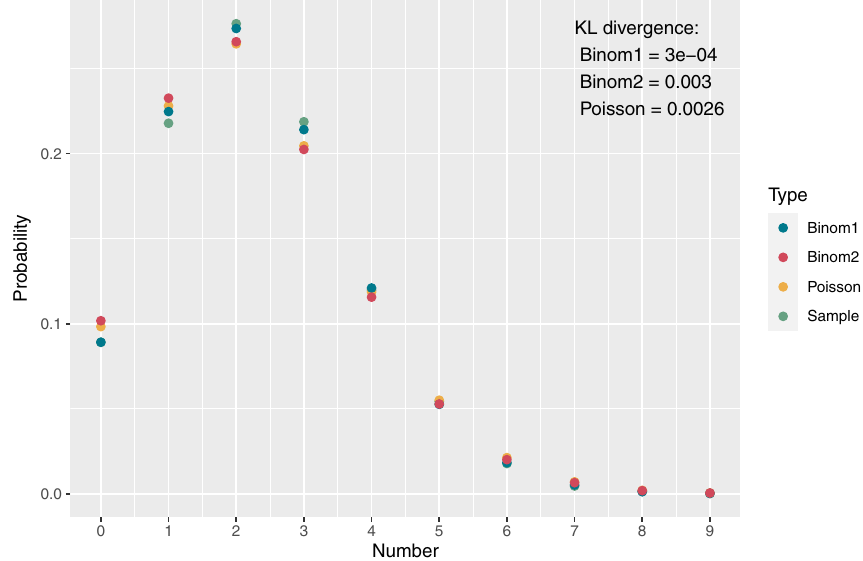
Figure 7. Comparison of approximations and simulated sampling distributions including Kulback-Leibler divergence. Parameters used were N = 600, 000 , x ′ k = 3, 312 , x k = 288 , n k = 17, 000 , and m k = 29